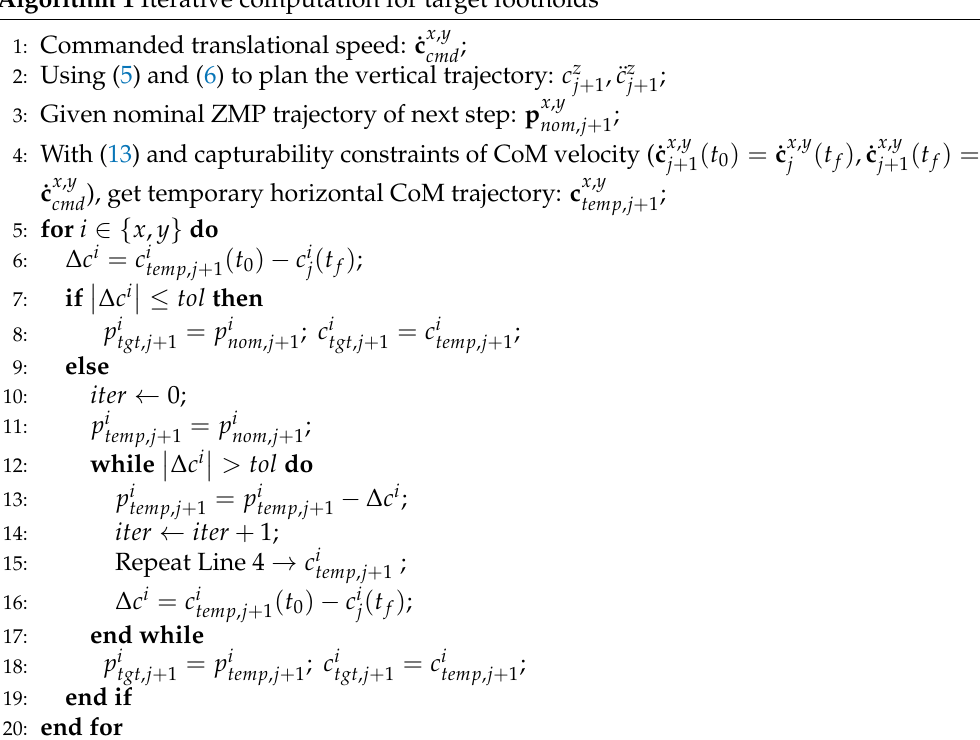
Algorithm 1 Iterative computation for target